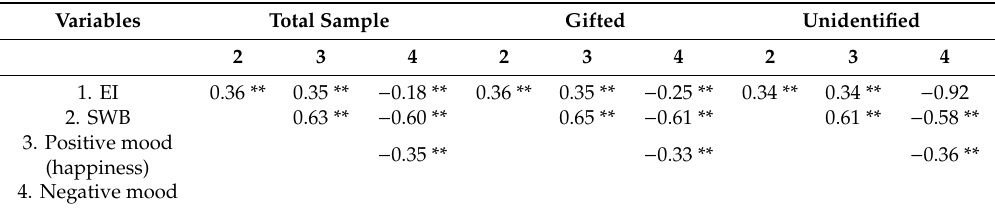
Table 2. Bivariate correlations